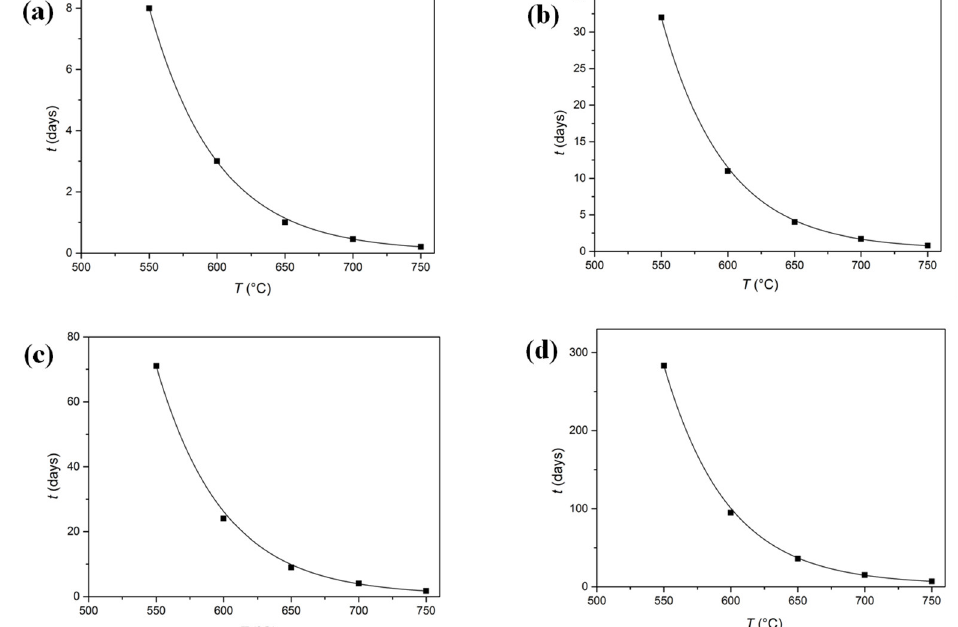
Table 2. Calculation results of Sn diffusion in the Cu substrate.